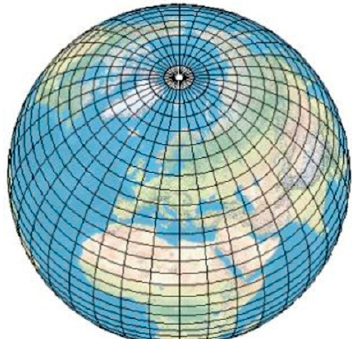
Figure 12. Illustration of the data redundancy of GTOPO30: The sampling diagram of GTOPO30 in which the arc intervals of latitude and longitude for cells are uniform (source—cited from